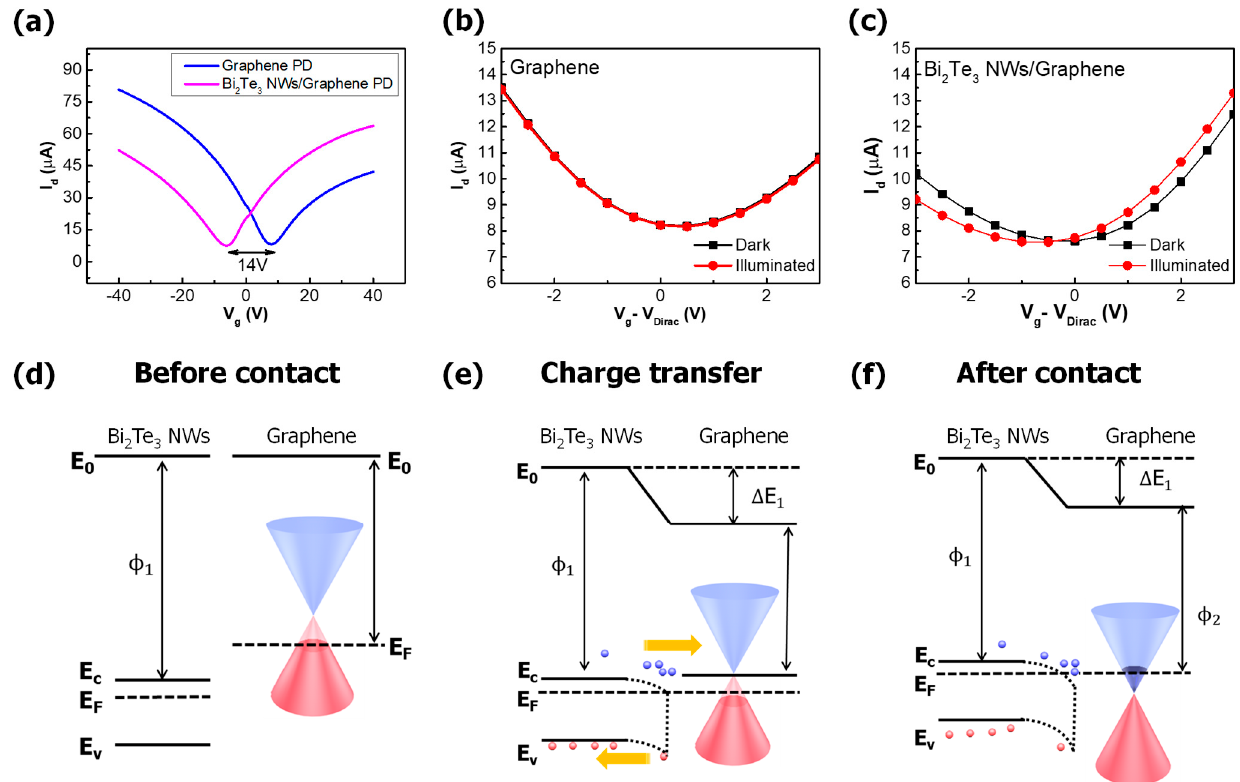
Figure 3. Band diagrams for graphene/Bi 2 Te 3 NWs junction contact ( a ) before contact formation, ( b ) charge transfer during contact, and ( c ) after contact formation with Bi 2 Te 3 NWs and graphene. E 0 is the vacuum level; E F is the Fermi level; E c and E v are conduction and valence bands of graphene and Bi 2 Te 3 NWs, respectively; and ϕ 1 and ϕ 2 are work functions of Bi 2 Te 3 NWs and graphene, respectively. ( d ) I d -V g characterization of graphene only device (in blue) and Bi 2 Te 3 NWs decorated device (in purple). ( e , f ) I d -V g characterization under 980 nm illumination with an intensity of 1 mW/cm 2 .